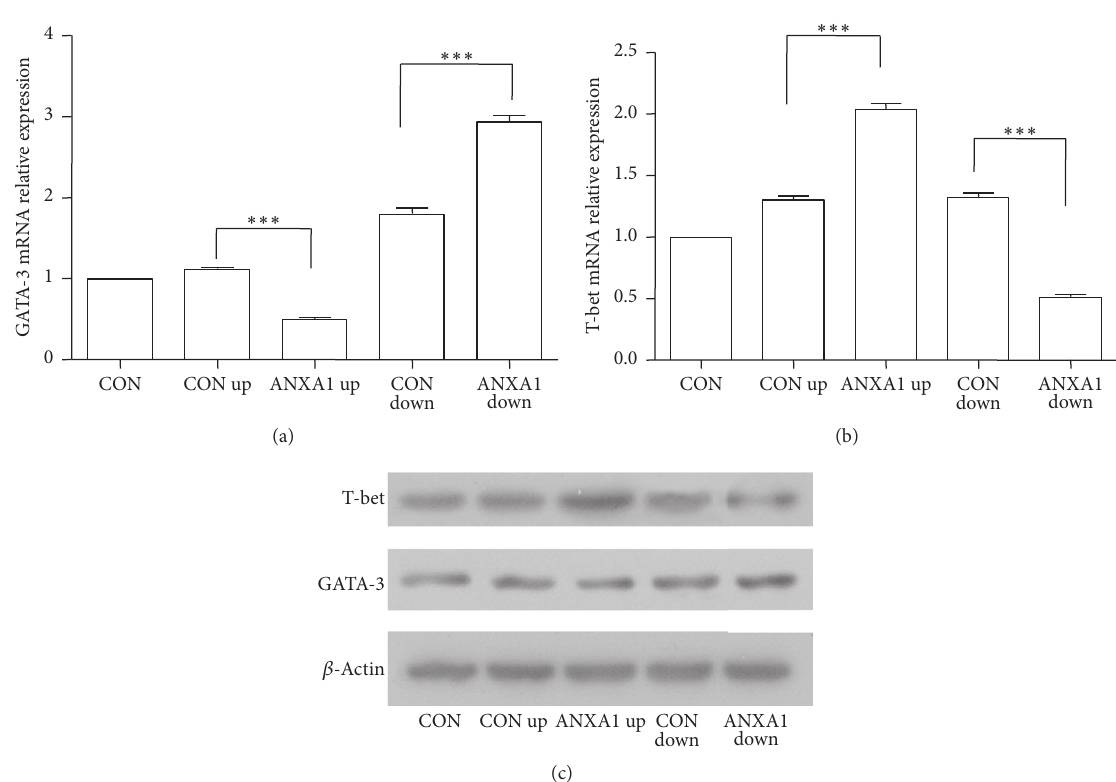
Figure 3: ANXA1 modulates GATA-3 and T-bet expression in Th0 conditions. CD4 + T cells were infected with ANXA1 up or ANXA1 down Lentivirus in Th0 condition and then stimulated with anti-CD3/CD28 (5.0 𝜇 g/mL) for 8 h to analyze T-bet and GATA-3 expression by real- time PCR (a, b) and western bolt (c). ∗∗∗ 𝑝 < 0.001 .